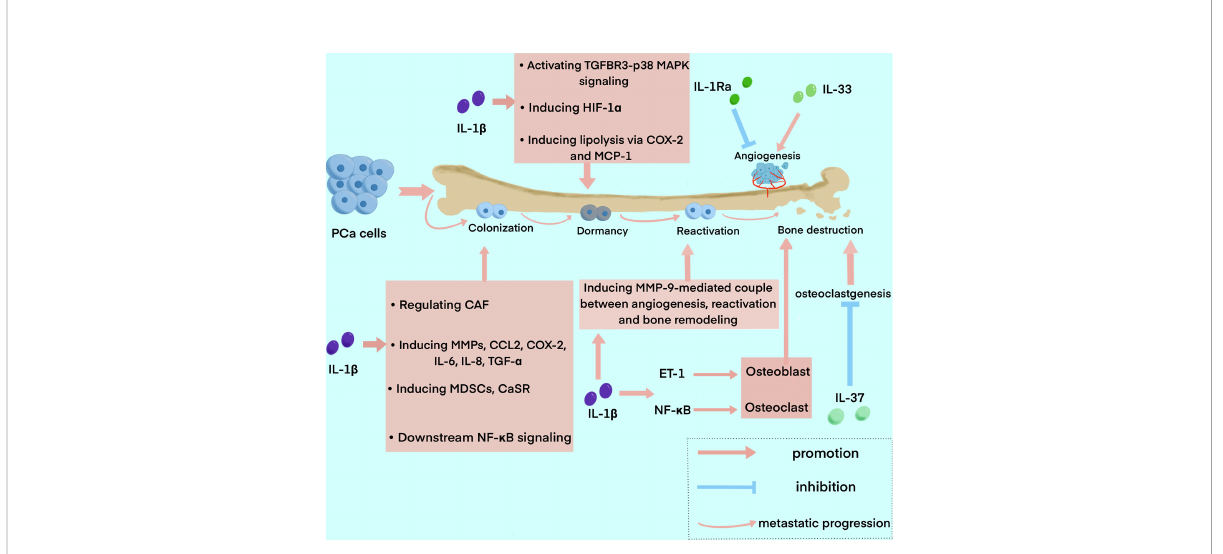
FIGURE 3 The roles of IL-1 family in the process of bone metastasis in PCa. The diagram summarized the major functions of IL-1 family exert in the process of bone metastasis, including colonization, dormancy, reactivation, and bone destruction. IL1 b is widely involved in the whole process, while IL-1Ra, IL-33, and IL-37 mainly play a role in angiogenesis and bone